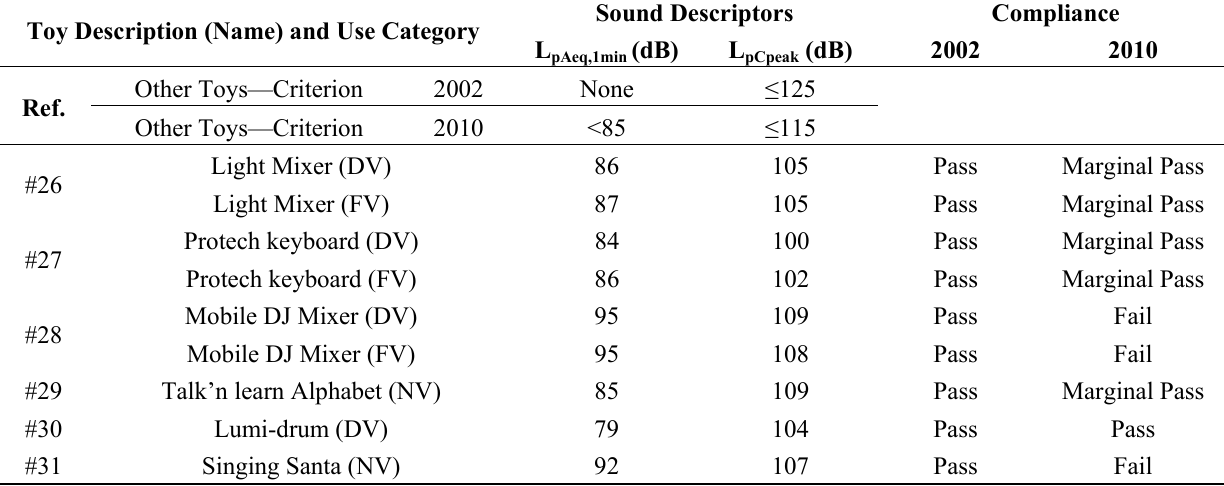
Table 4. Compliance of “Other Toys” against the AS/NZ ISO 8124.1:2002 and 2010 standards.